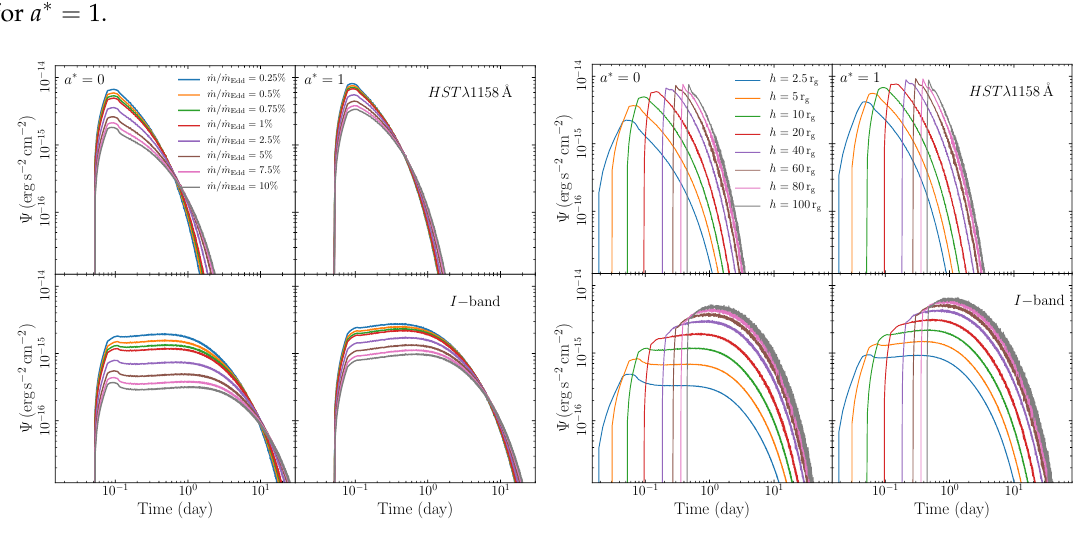
Figure 1. ( Left panel ) Response functions for the various ˙ m values we considered ( h = 10 r g ). ( Right panel ) the same for the various h values we considered ( ˙ m = 0.01 ˙ m Edd ). Left and right columns correspond to a ∗ = 0 and 1, respectively. Top and bottom rows show the responses for the HST λ 1158 and the I -band,